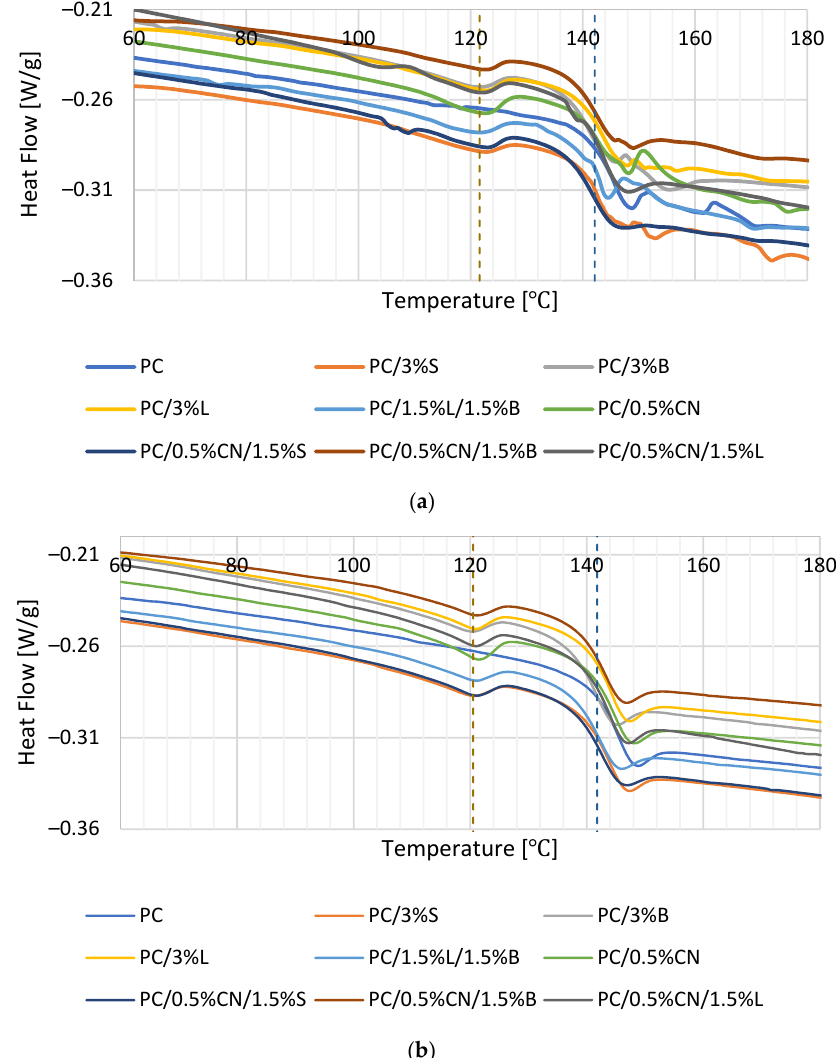
Figure 11. First heating ( a ) and second heating ( b ) curves for the composites. Table 6. Summary of T g and Delta C p changes after the first and second heating steps of the indi- vidual compositions.